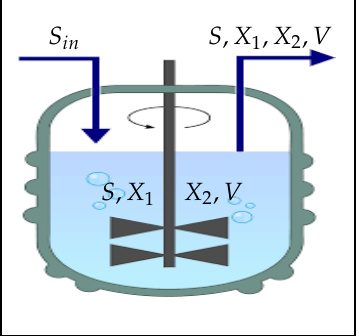
Figure 1. A bioreactor(chemostat) is a continuous stirring mechanism where a limiting nutriment was continuously added at an input concentration ( S in ), and the culture liquid ( S , X 1 , X 2 , V ) is continuously removed at the same flow rate ( D ).